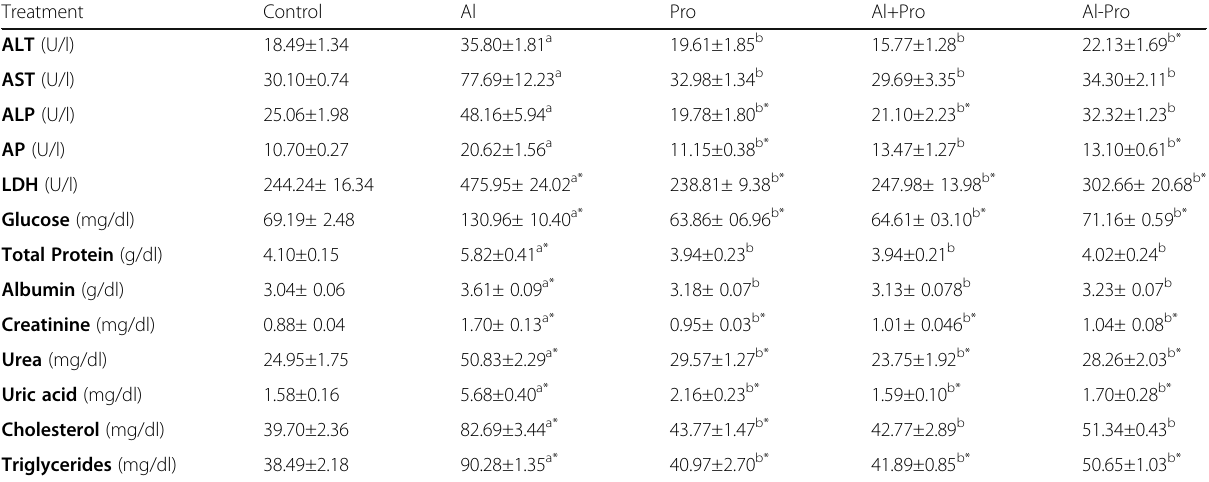
Table 1 The effect of AlC1 3 chloride (40 mg/kg b.w.), propolis (150 mg/kg b.w.), AlC1 3 combined with propolis and AlC1 3 choloride for one month followed by administration of AlCl 3 combined with propolis for another month on the biochemical parameters